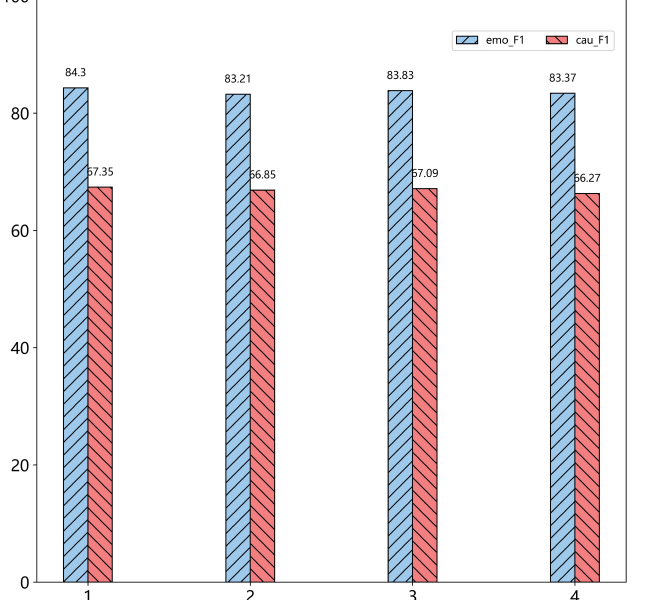
Figure 5. F1 changes of emotion clause extraction task and cause clause extraction task in different